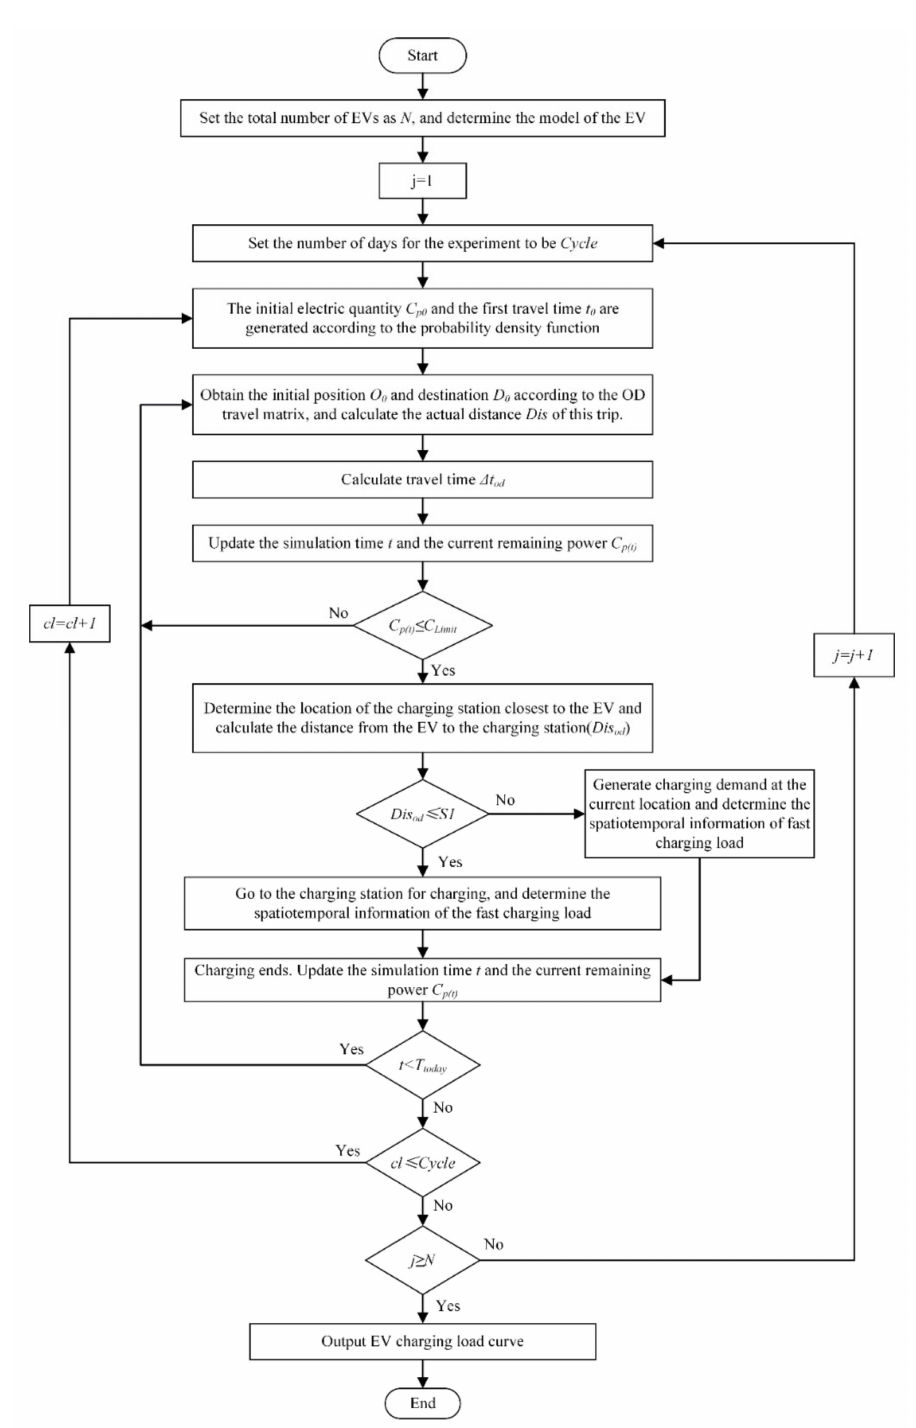
Figure 9. Flow chart of the spatiotemporal prediction model of electric taxi charging